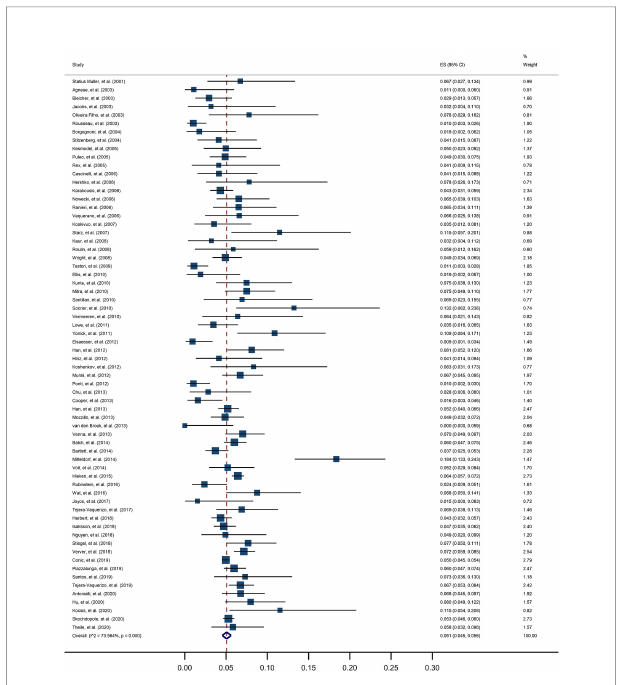
FIGURE 3 | Meta-analysis of sentinel lymph node biopsy positivity in thin